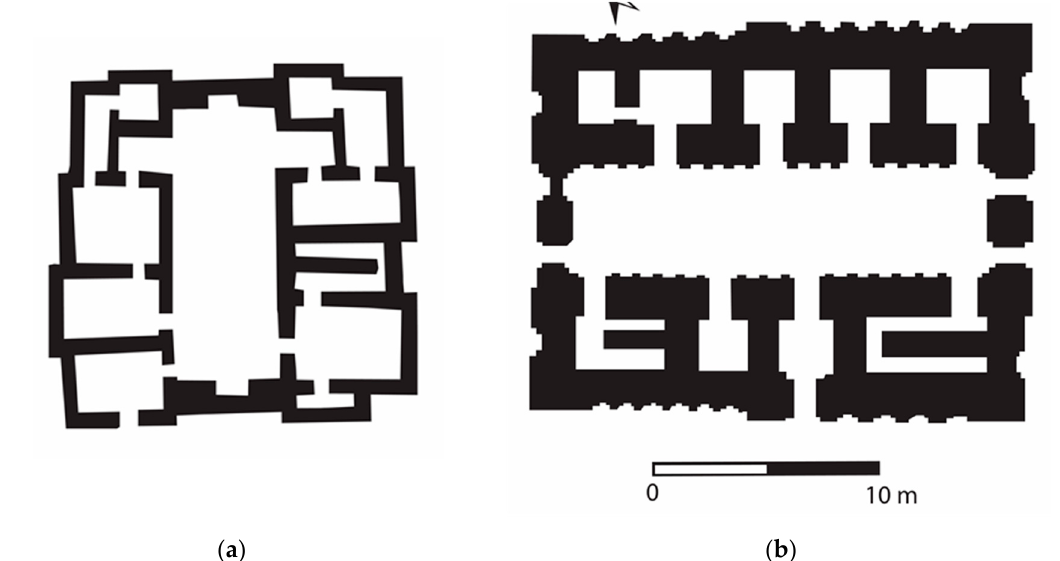
Figure 2. ( a ) Courtyard House (after Roaf 1995, 426 Figure 3e); ( b ) Tripartite Temple (White Temple) of the Uruk Period (after Roaf 1995, 430 Figure 7). © Copyright 2021 OCLC, Inc.